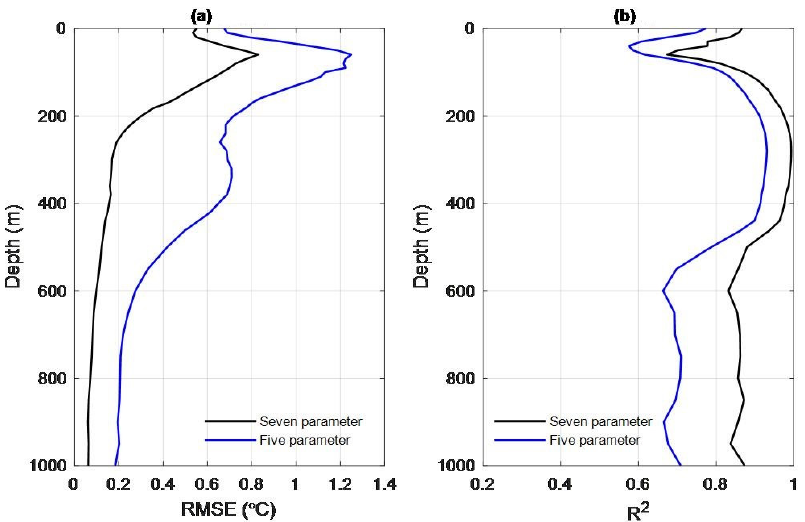
Figure 4. The estimation accuracy of the OSTS at different depths by the Ens-ML model based on ( a ) RMSE (°C) and ( b ) R 2 in different cases in 2019.